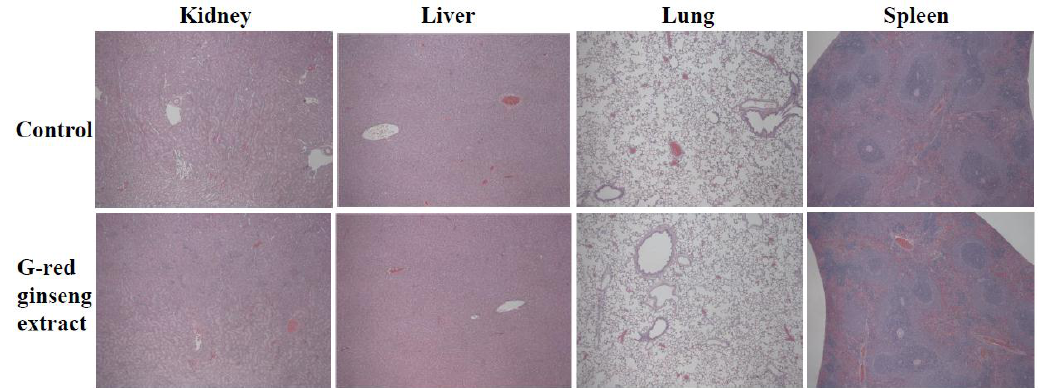
Figure 2. Normal histopathological sections of kidneys, liver, lungs and spleen in the control (DW) and G-red ginseng extract-treated rats after 14-day repeated oral administration. Images are magnified at 50×.